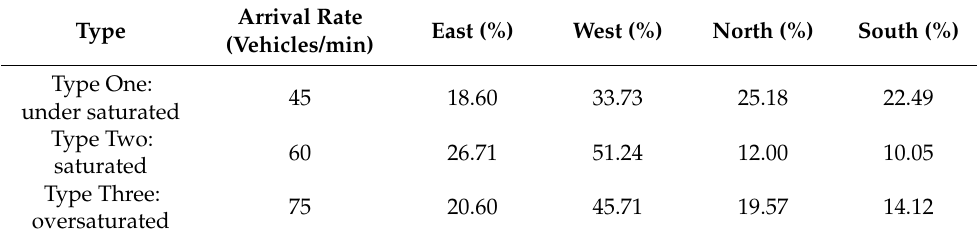
Table 3. Proportion of simulation type.